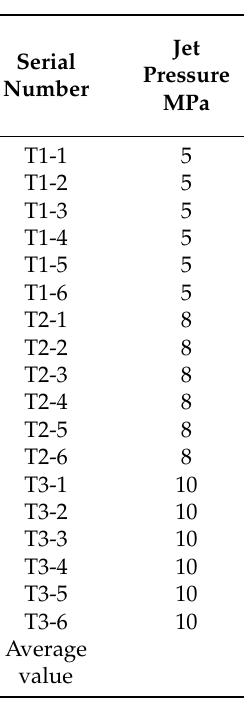
Table 4. Proportion of erosion surface straight-line